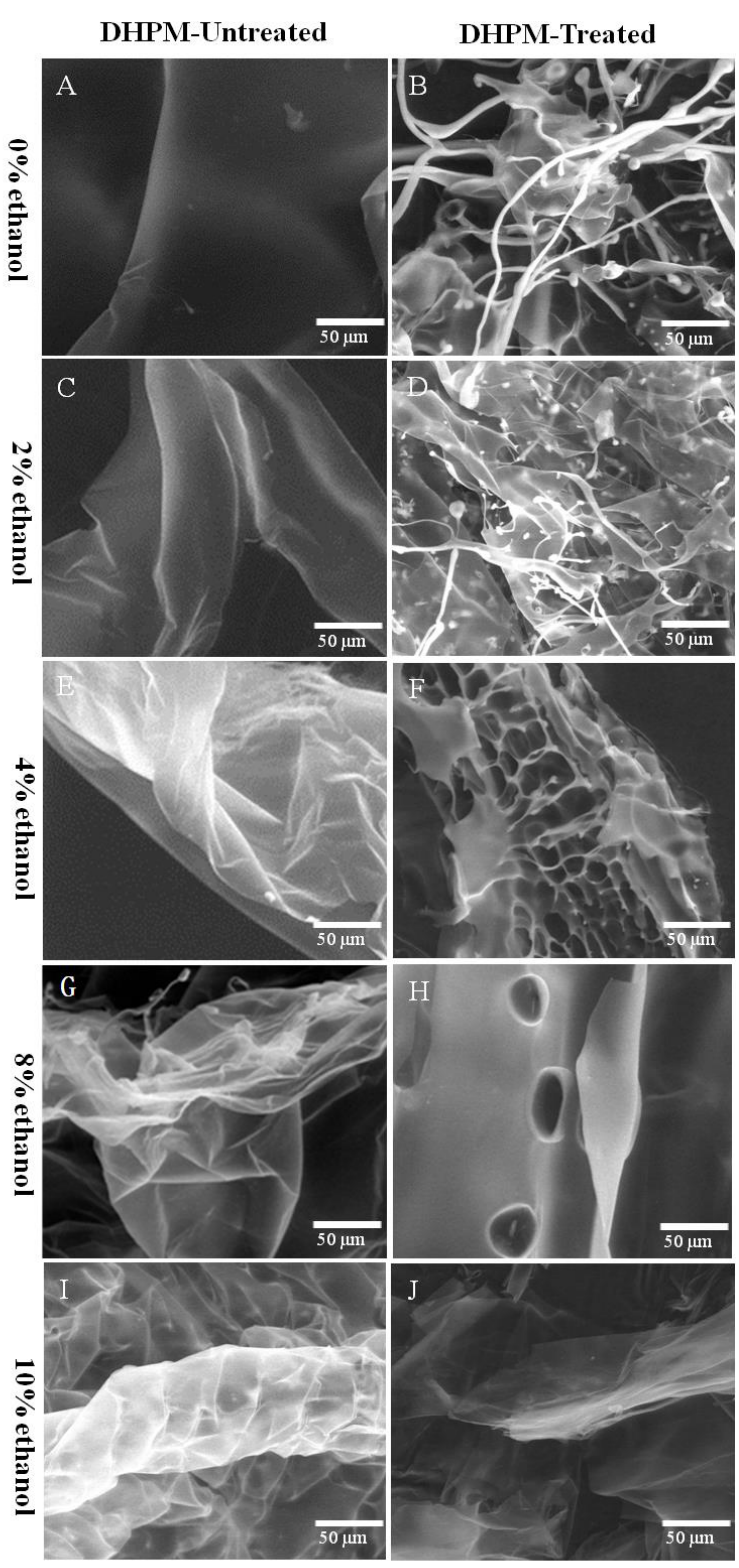
Figure 4. Environmental scanning electron micrograph of pectin treated with or without DHPM under different ethanol